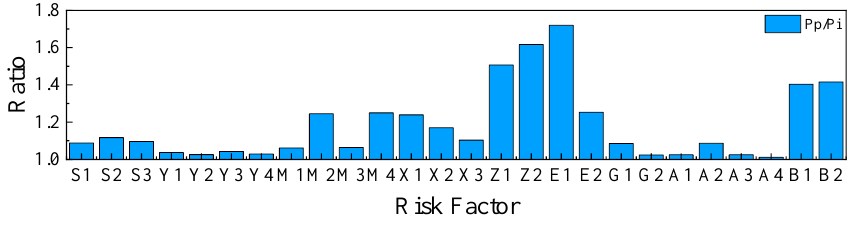
Figure 12. Ratio of risk factors.